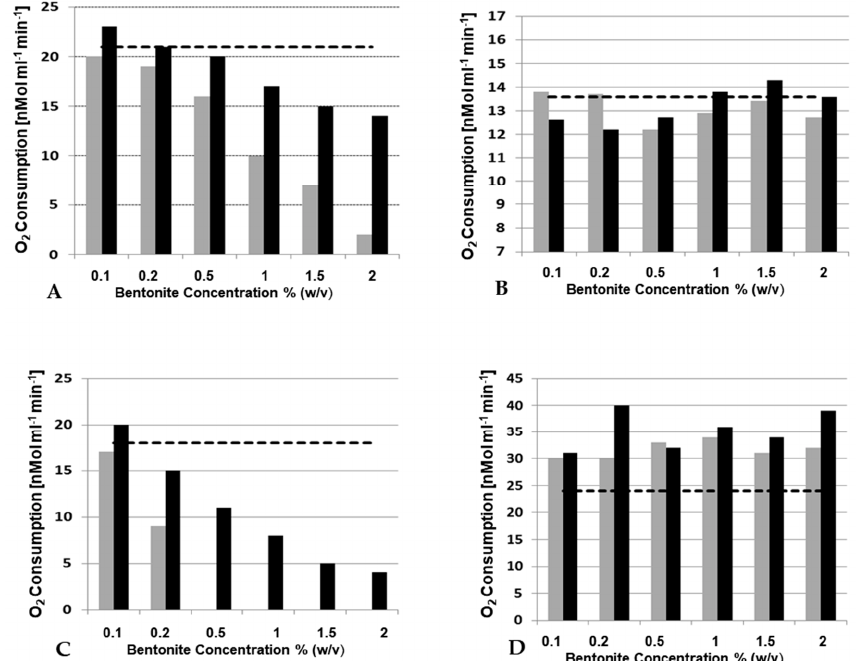
Figure 6. Effect of different bentonite concentrations on laccase PpL [36]. ( A ) in water; ( B ) in white grape juice; ( C ) in white wine; and ( D ) in red wine. Activity measurement in the supernatants was performed after one hour incubation at 20 °C by measururing the oxygen consumption by laccase (substrate 5 mM caffeic acid). The horizontal dotted lines mark the laccase activity without bentonite additions. Grey columns, Sodibent Supra® and black columns, NaCalit®.